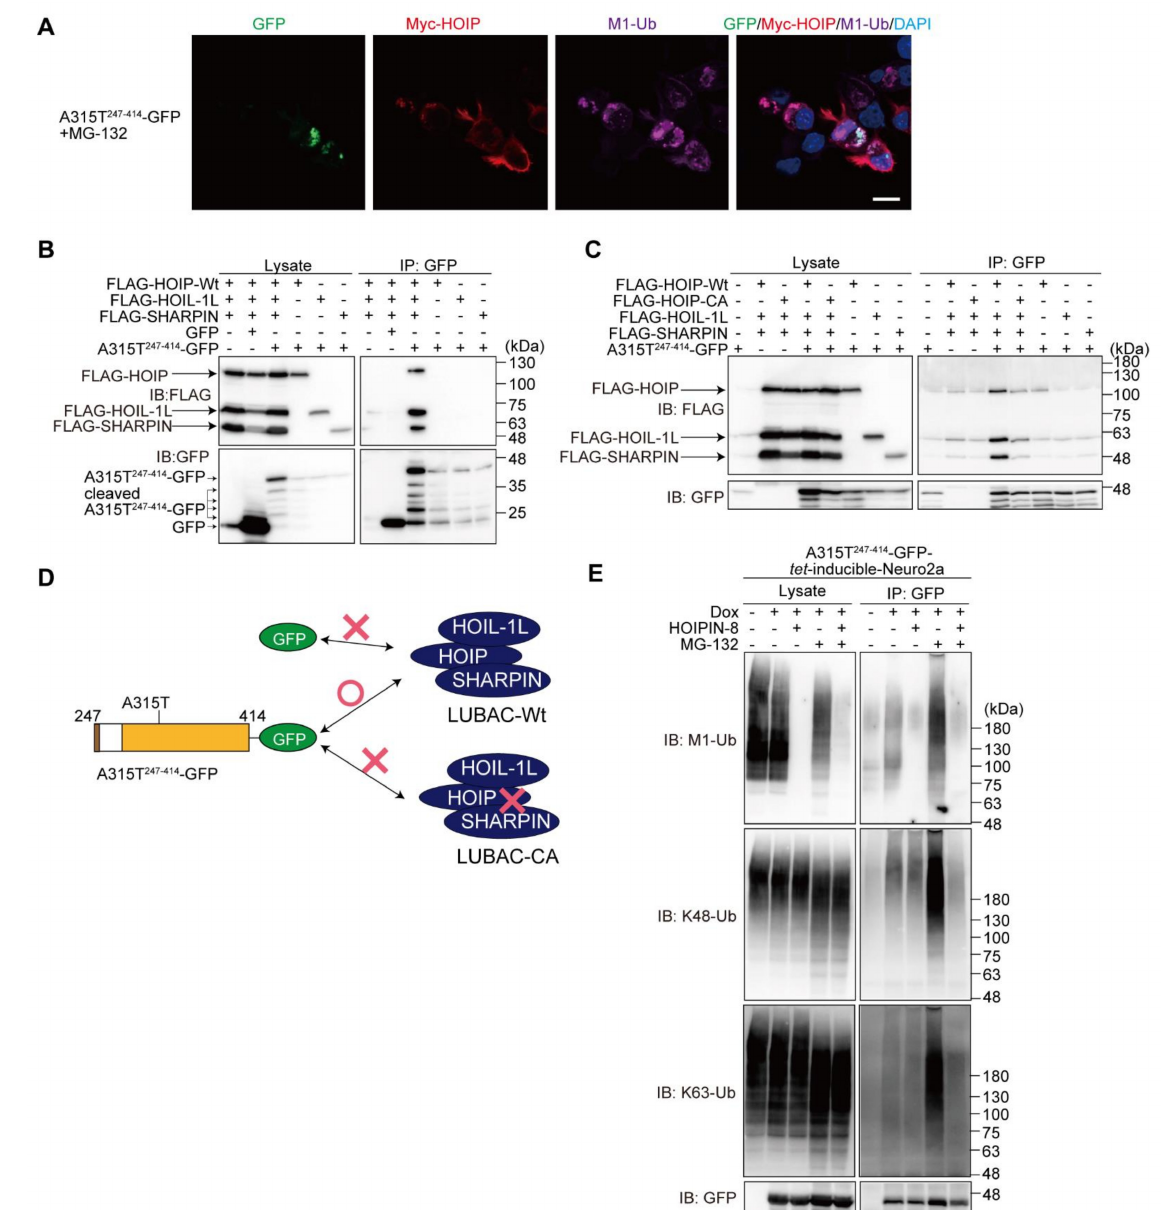
Figure 6. LUBAC activity is necessary for binding truncated TDP-43. ( A ) Colocalization of TDP-43 aggregates, LUBAC, and M1-ubiquitin. After the overexpression of LUBAC and A315T 247-414 -GFP in the presence of MG-132, immunofluorescence analyses of GFP, Myc-HOIP, and M1-ubiquitin were performed. Bar = 10 µ m. ( B ) A315T 247-414 -GFP binds the LUBAC complex. FLAG-tagged LUBAC subunits, GFP, and/or A315T 247-414 -GFP were transfected into the HEK293T cells as indicated. Cell lysates and anti-GFP immunoprecipitates were immunoblotted with the indicated antibodies. ( C ) A315T 247-414 -GFP binds active LUBAC. A similar analysis as in ( B ) was performed, using WT or the active site C885A mutant of human HOIP, HOIP-CA. ( D ) A scheme of the truncated TDP-43- LUBAC binding. The results of ( B , C ) are summarized. ( E ) The effects of LUBAC and proteasome inhibitors on the M1-, K48-, and K63-ubiquitinations of A315T 247-414 -GFP. The A315T 247-414 -GFP- tet-inducible Neuro2a cells were treated with 1 µ g/mL Dox and 10 µ M HOIPIN-8 for 18 h, with 2 µ M MG-132 added for the last 6 h, as indicated. Cell lysates obtained by the hot-SDS method and anti-GFP immunoprecipitates were immunoblotted with the indicated